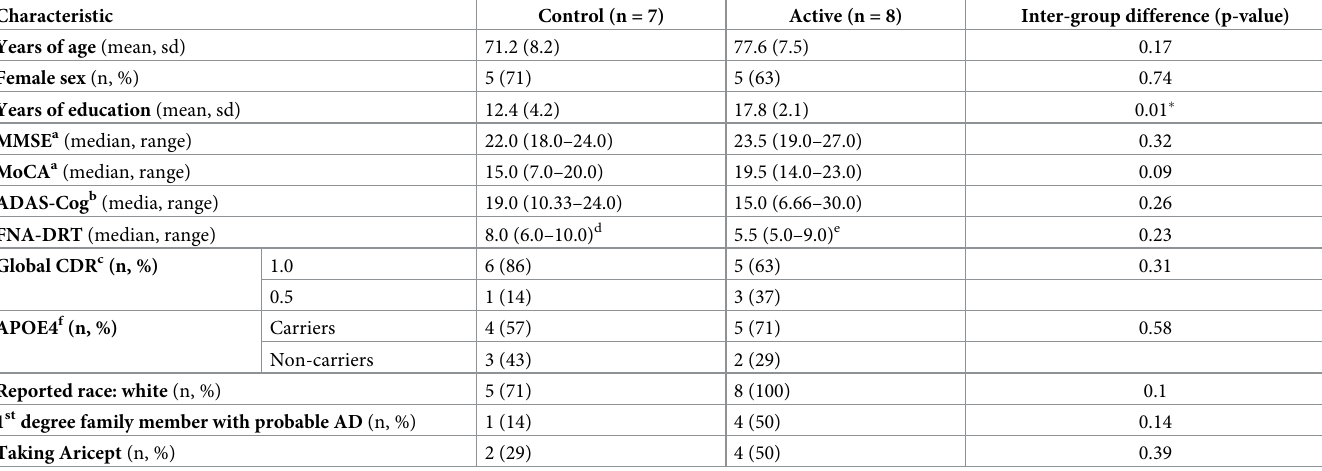
Table 2. Demographics and baseline clinical characteristics of Phase 2A study participants (AD patients).